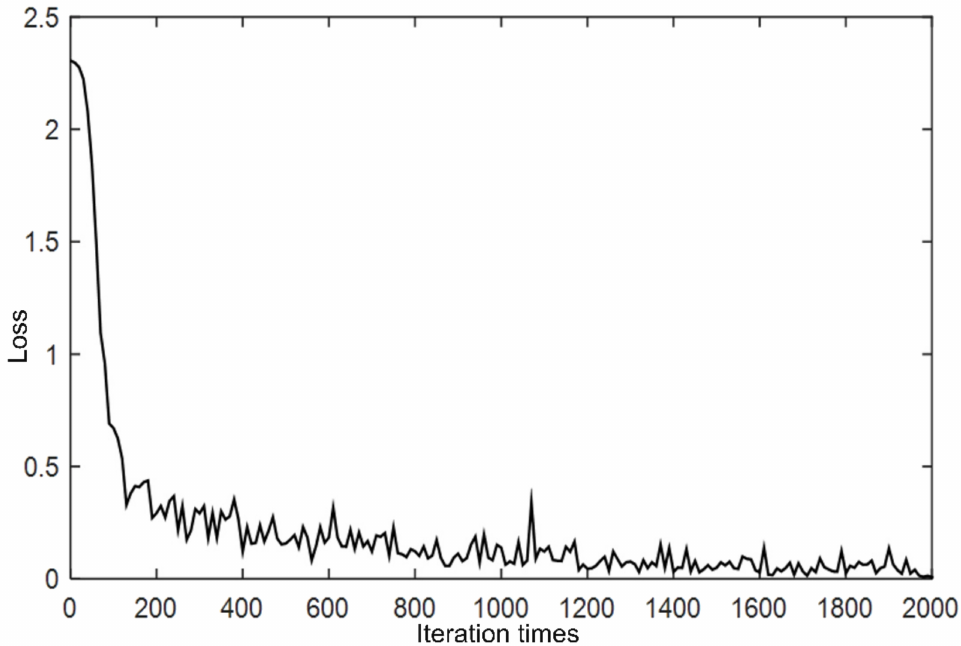
Figure 7. Loss function in training of 1D-convolutional neural